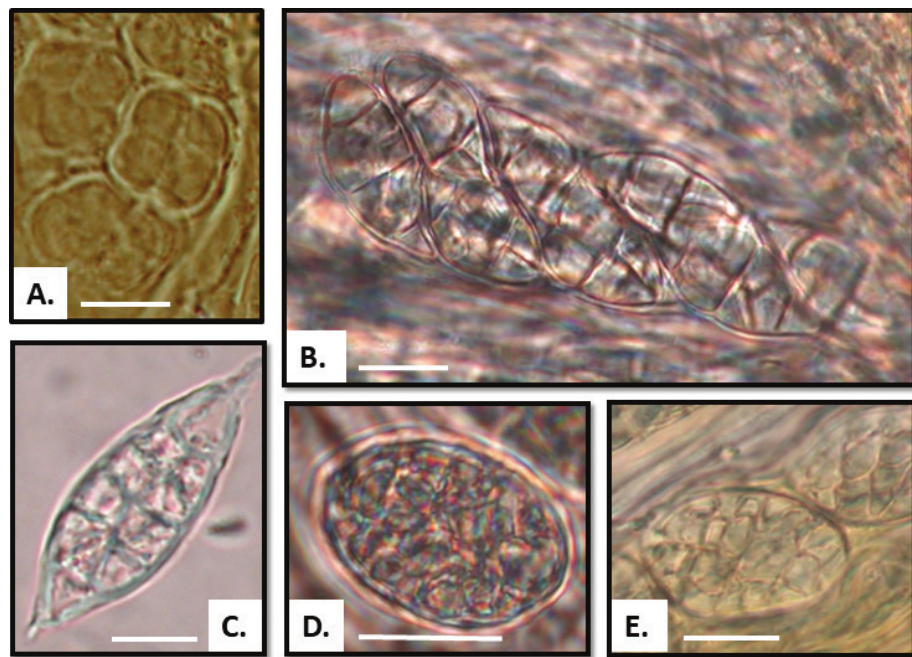
Figure 5. Ascospores: A Rostania quadrifida (McCune 2744, UPS), cubic spores with 2–5 cells B Rostan- ia paramensis (Palice 2796, holotype of Collema paramense ), ellipsoid spores with acute ends C Leptogium azureum (Tehler 3140, S), ellipsoid spores with acute ends D Scytinium sp. (Palice 2273), oblong spores, E Scytinium sp. (Palice 2274), oblong spores. Scale bar = 10